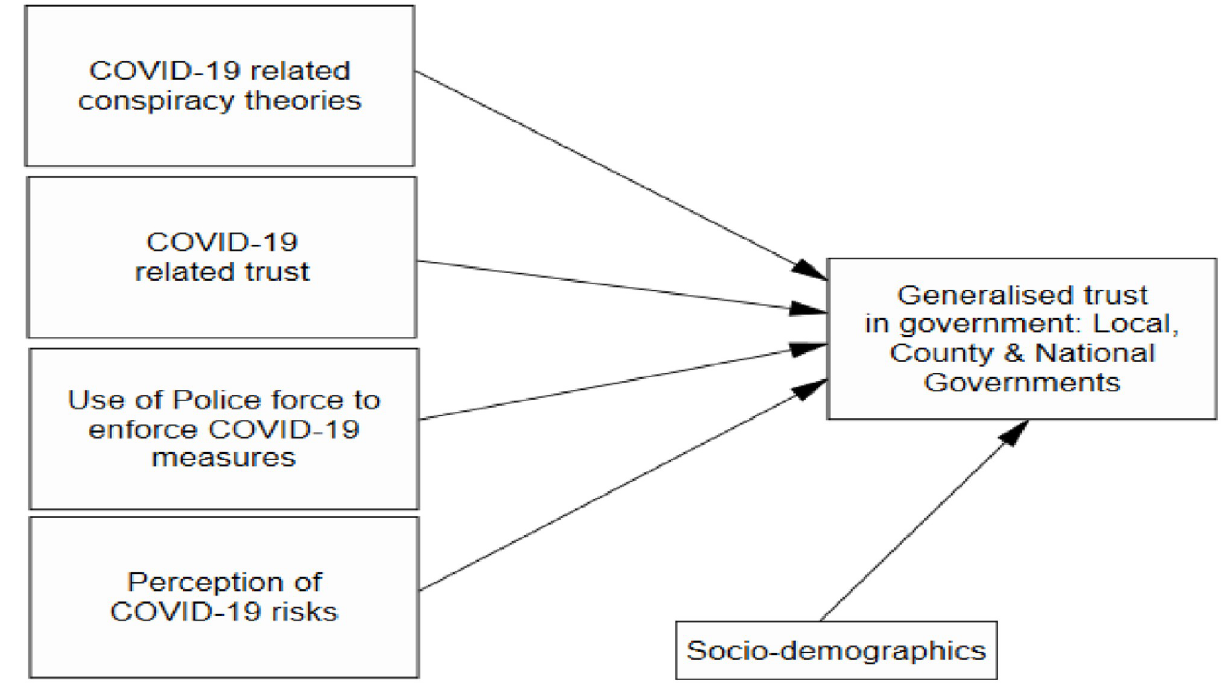
Fig 1. The conceptual